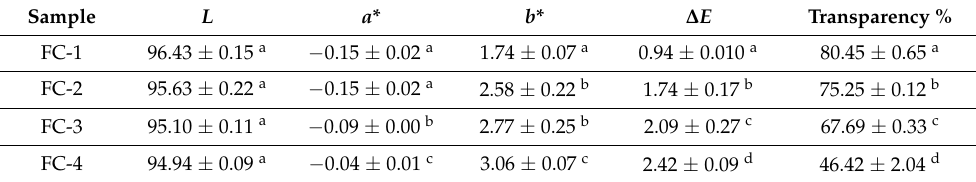
Table 3. Colour parameters and transparency of the CS–SA-based edible